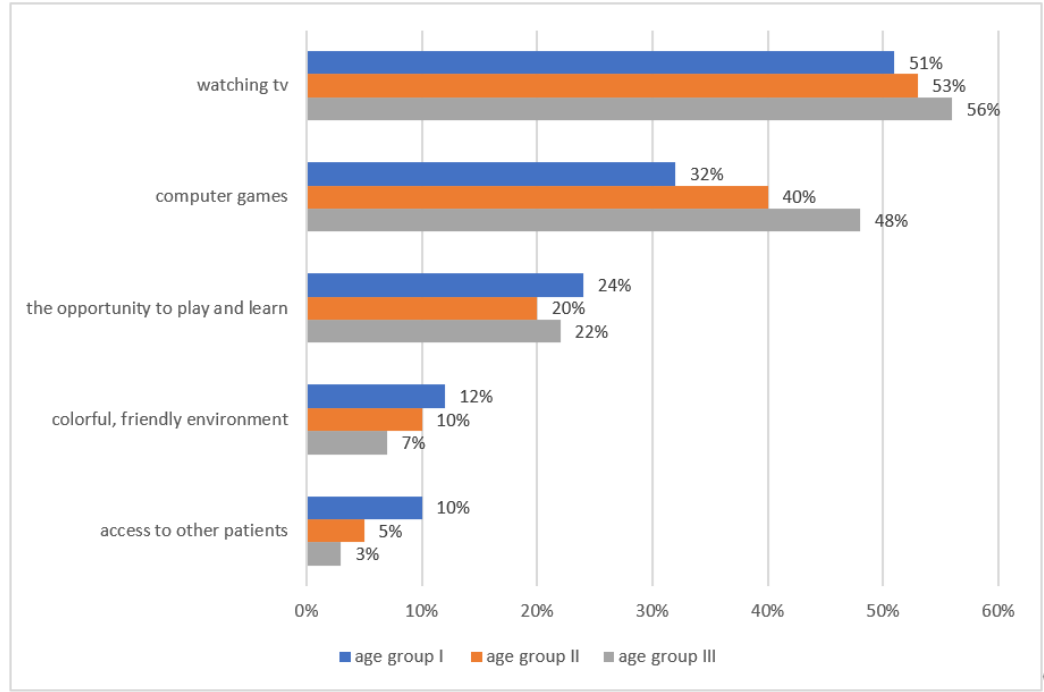
Figure 4. Hospital facilities appreciated by respondents.